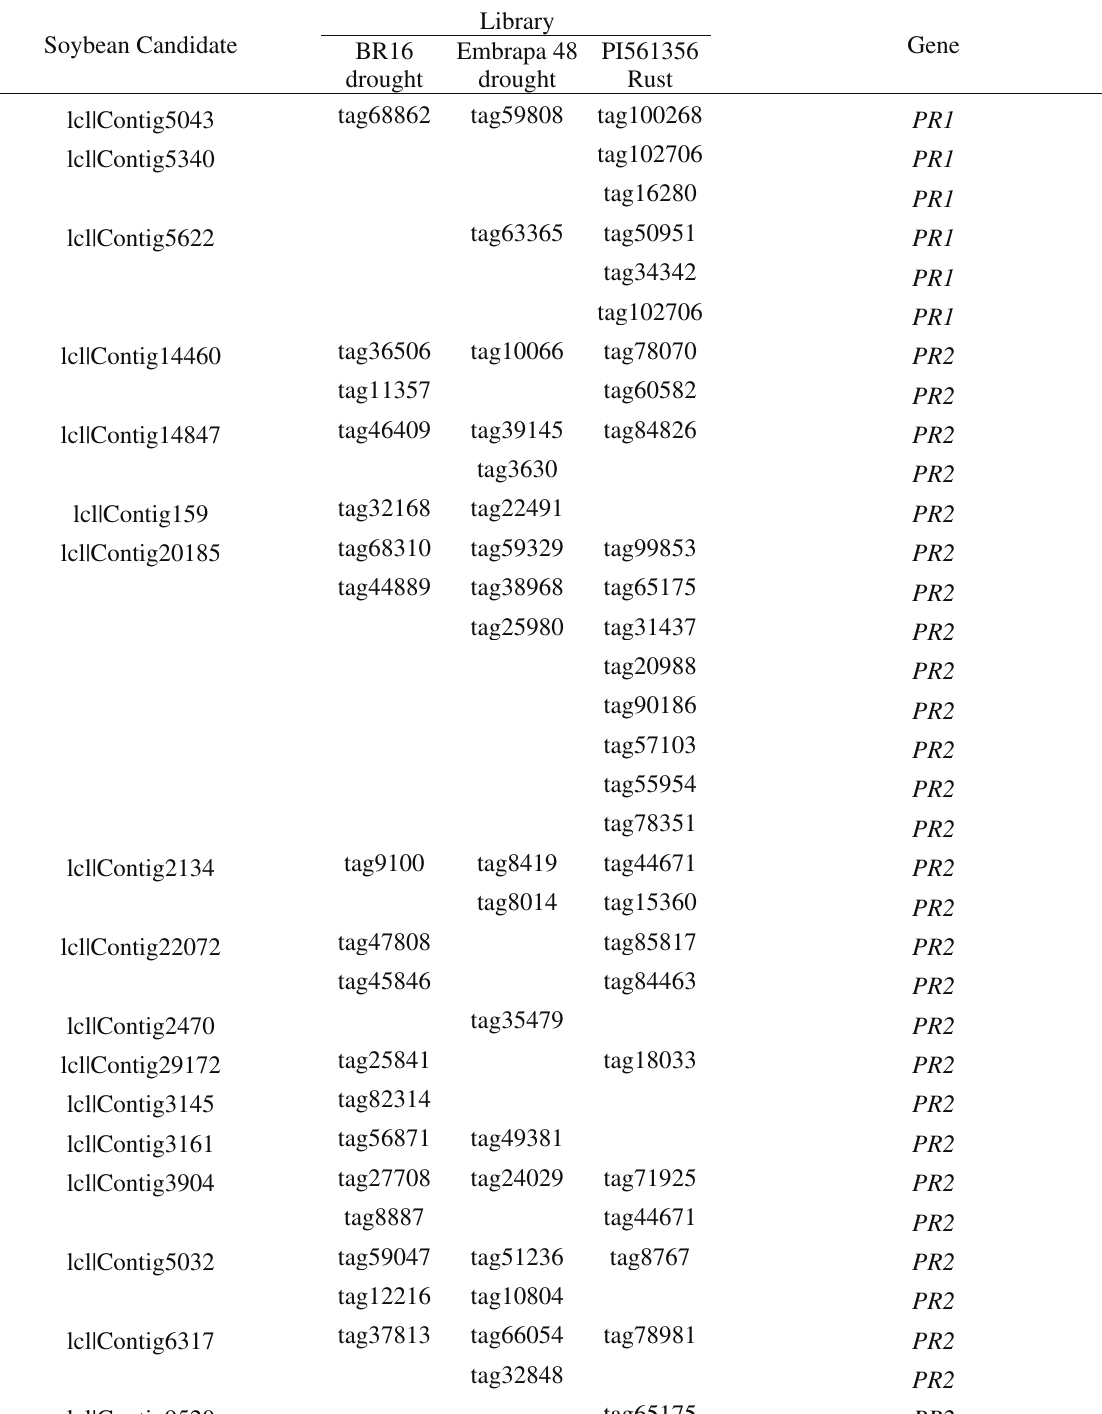
Table S3 - SuperSAGE tags that matched to the procured genes in each library comparison, considering: (1) BR-16 (drought susceptible stressed plants vs. negative control); (2) Embrapa-48 (drought tolerant plants after stress vs. negative control), and (3) PI561356 (rust fungus resistant plants after stress vs. negative